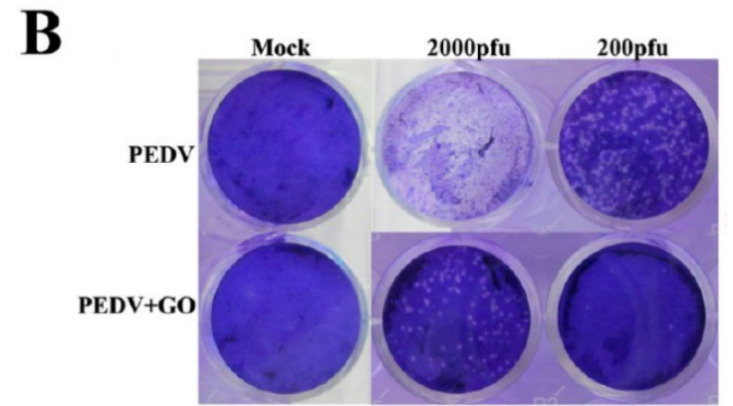
Figure 6. Antiviral activity of GO (6 µ g/mL) on PK-15 cells ( A ) and Vero cells ( B ). ( A ) Cells infected with PRV of 200 or 2000 pfu. ( B ) Cells infected with PEDV of 200 or 2000 pfu. Clear spots represent the amount of virus. Mock-infected cells serve as a control. Reprinted with permission from [89] .